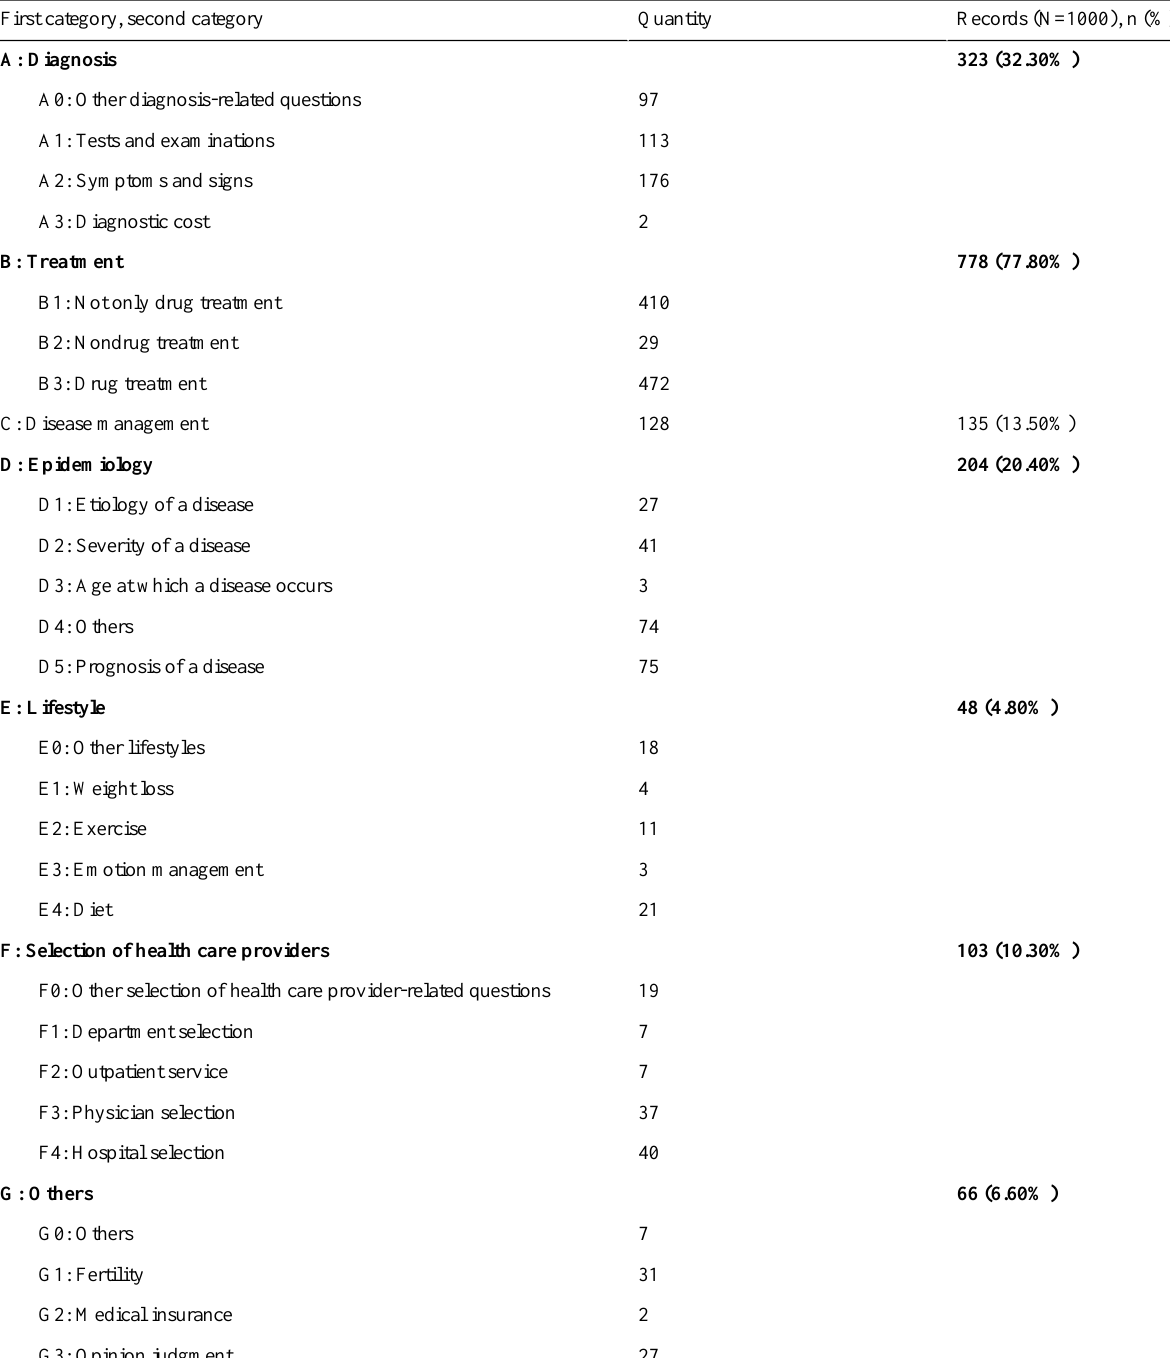
Table 3. Distribution of second-class codes of question